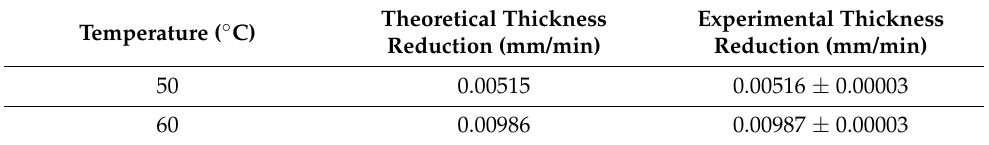
Table 2. Thickness reduction per surface e at 4 M as a function of temperature.